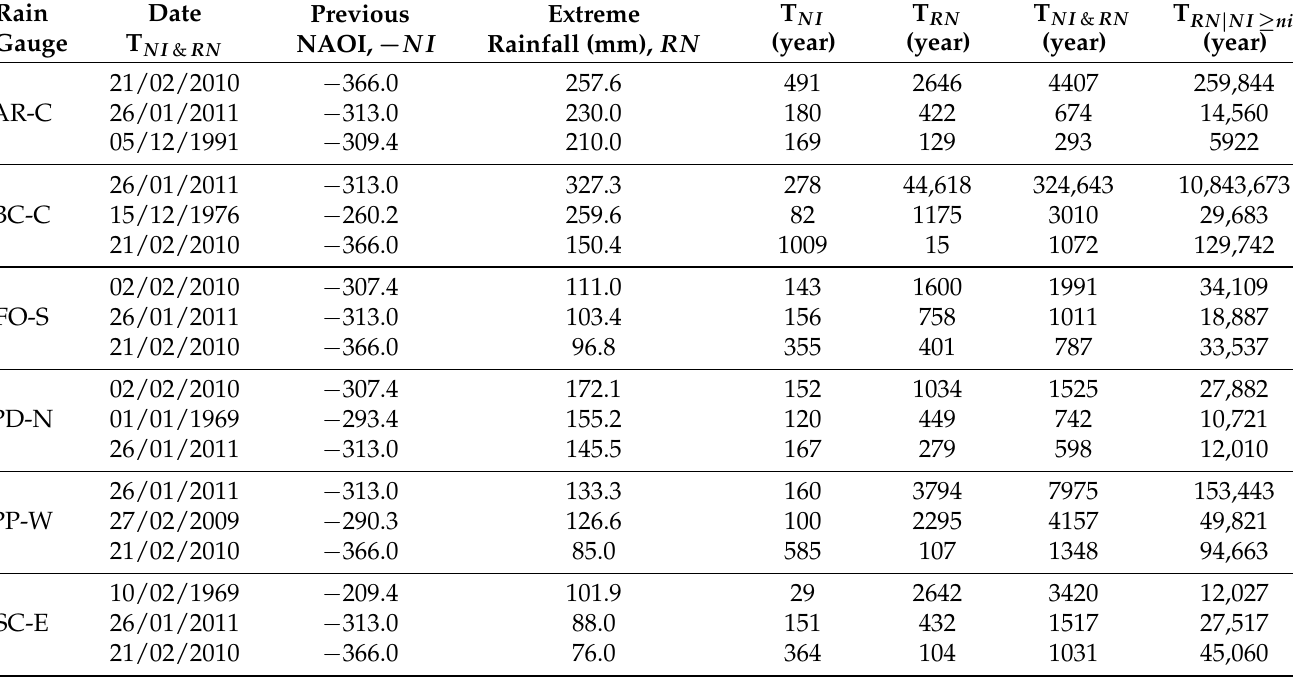
Table 5. At each of the six rain gauges, dates and characteristics of the three bivariate observations (previous NAOI and extreme daily rainfalls) with the highest return periods T NI a ndRN and their corresponding univariate, bivariate, and conditional return periods rounded to the nearest integer in